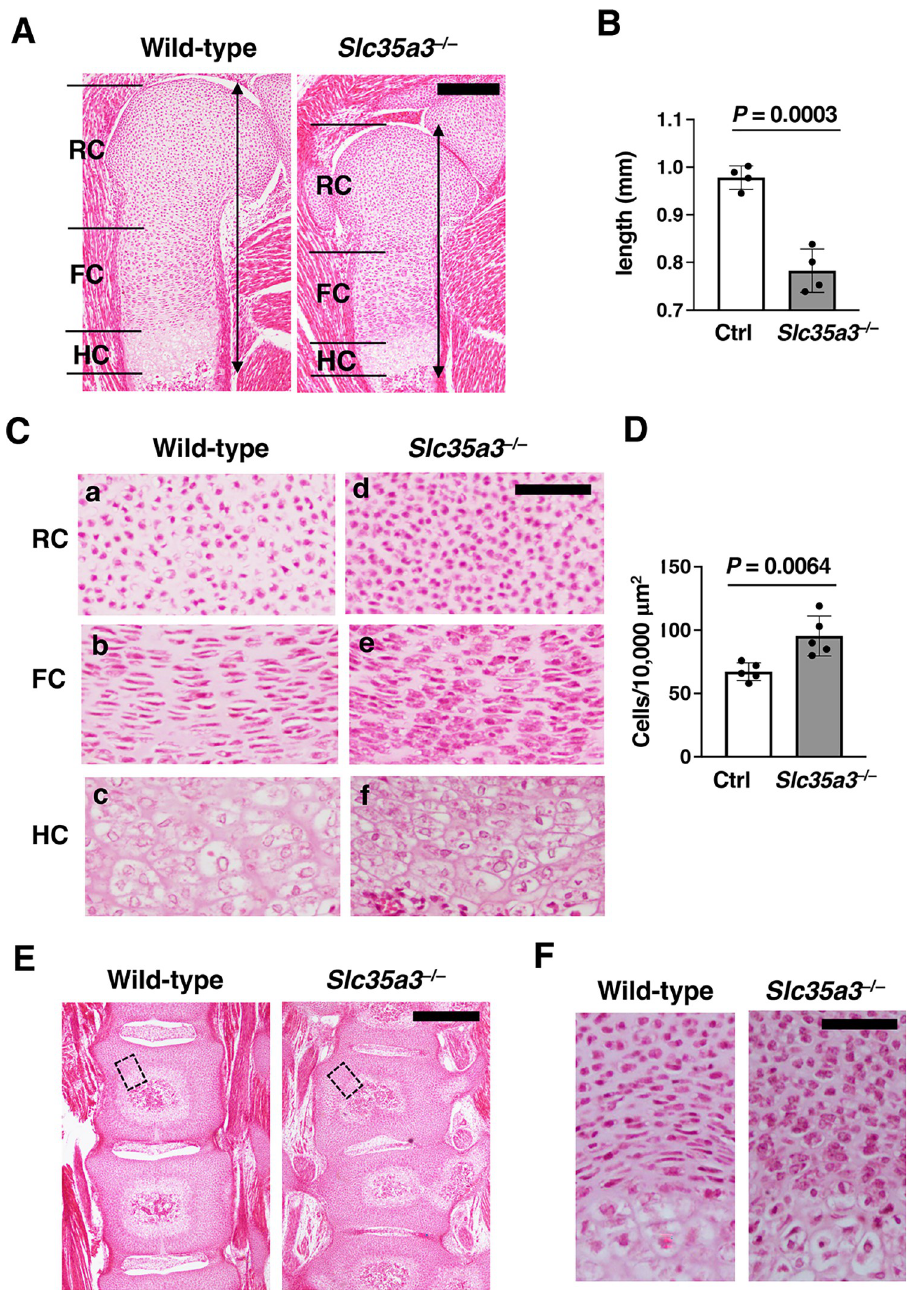
Fig 4. Cartilaginous extracellular matrix space was severely reduced in Slc35a3 –/– mice. Humerus and lumbar vertebrae sections of Control (Ctrl, wild-type + Slc35a3 +/– ) and Slc35a3 –/– littermate embryos at E18.5 were stained using hematoxylin and eosin (HE) solution. (A) Low magnification images of the humerus. Black double arrows indicate the length of the distal growth plate. (B) Lengths of the humerus growth plate in the HE-stained sections prepared from Ctrl and Slc35a3 –/– embryos were measured. (C) High magnification images of the round chondrocyte (RC), flat chondrocyte (FC), and hypertrophic chondrocyte (HC) zones in the growth plates. (D) Cells were counted in the round chondrocyte zone of HE-stained sections within the squares (100 × 100 μ m). (E) Low magnification images of the lumbar vertebrae. (F) High magnification images of the lumbar vertebrae. The boxed regions in (E) are shown at a higher magnification in (F). Data are shown as the means ± standard deviation; n = 4 (B) and 5 (D). P values were calculated using Student’s t -test. Ctrl, control. Scale bars, 200 μ m (A, E) and 50 μ m (C, F).